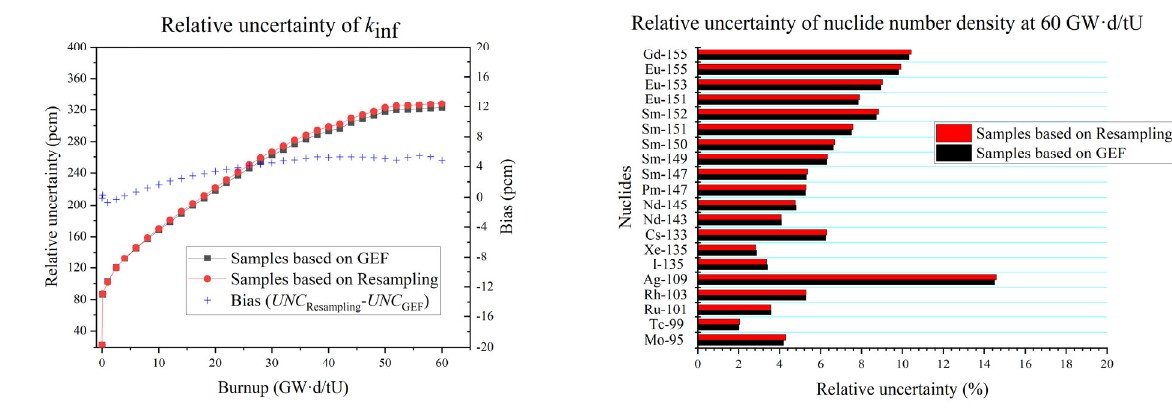
Fig.6. Comparison of uncertainties of the TMI-1 problem based on fission yield samples from joint